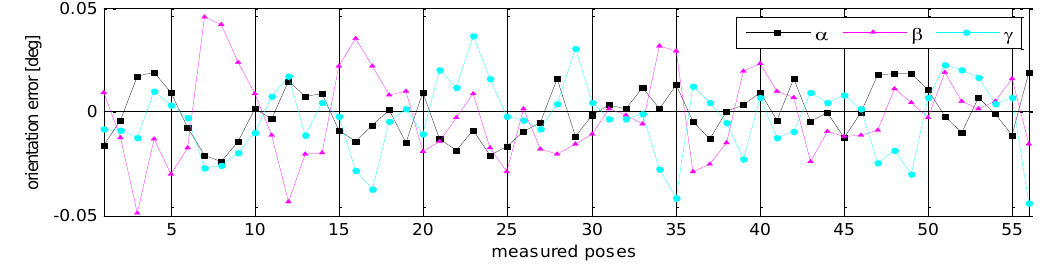
Figure 13. Robot’s absolute position accuracy (validation, pose set Q